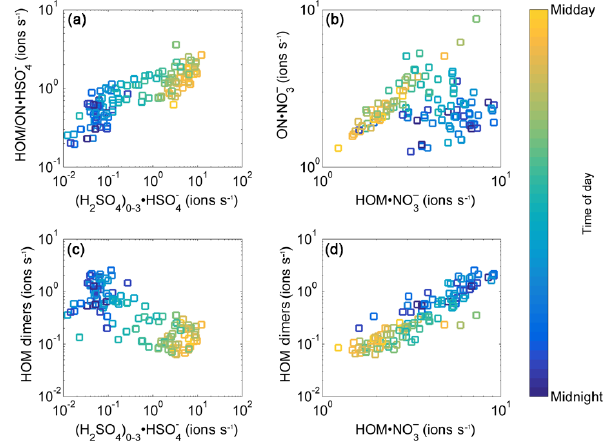
Figure 7. The diurnal dependency of ambient ions detected by the APi-TOF. The data points are hourly averages for 5 sunny days dur- ing April–May 2013. The colour scale is normalised to show the period between midnight and midday, so that the transition between blue to green is around 06:00 and